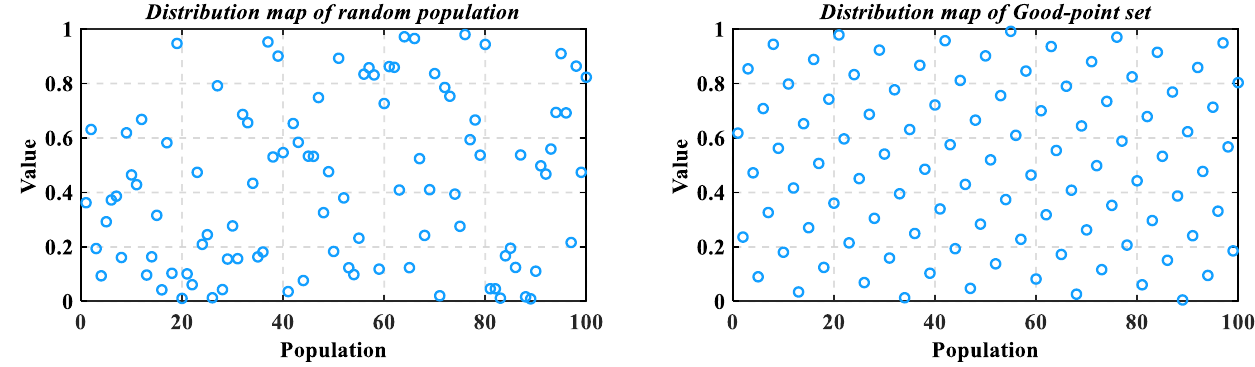
Figure 4. Comparison of two different initialization strategies.